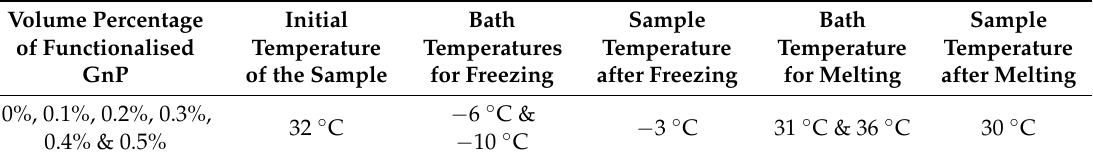
Table 1. Freezing and melting test